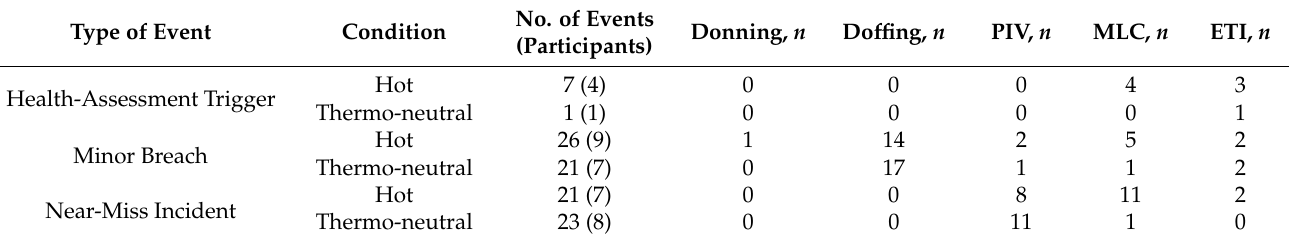
Table 3. Health-assessment triggers, minor breaches, and near-miss incidents. Type of